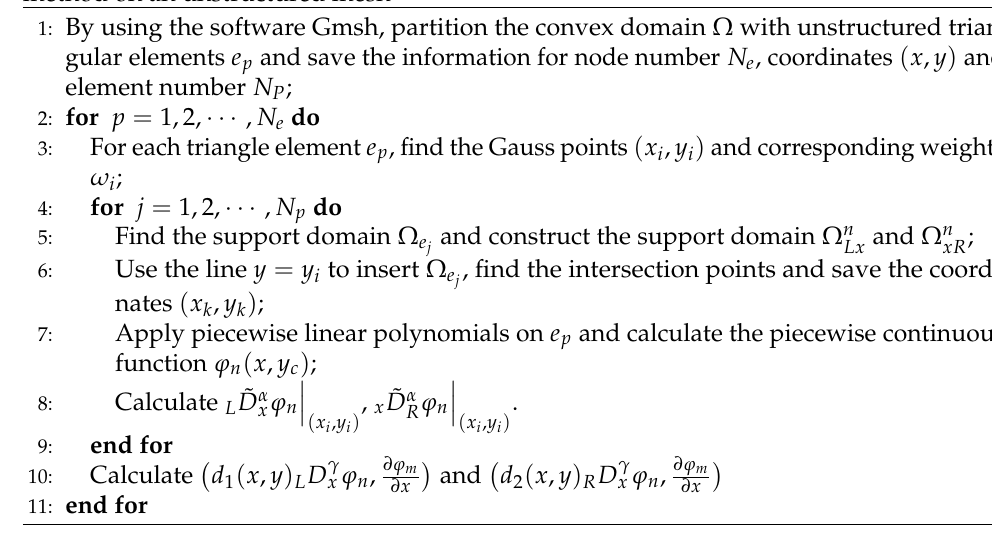
Algorithm 1 Calculate ( d 1 ( x , y ) L D γ x ϕ n , ∂ϕ m method on an unstructured